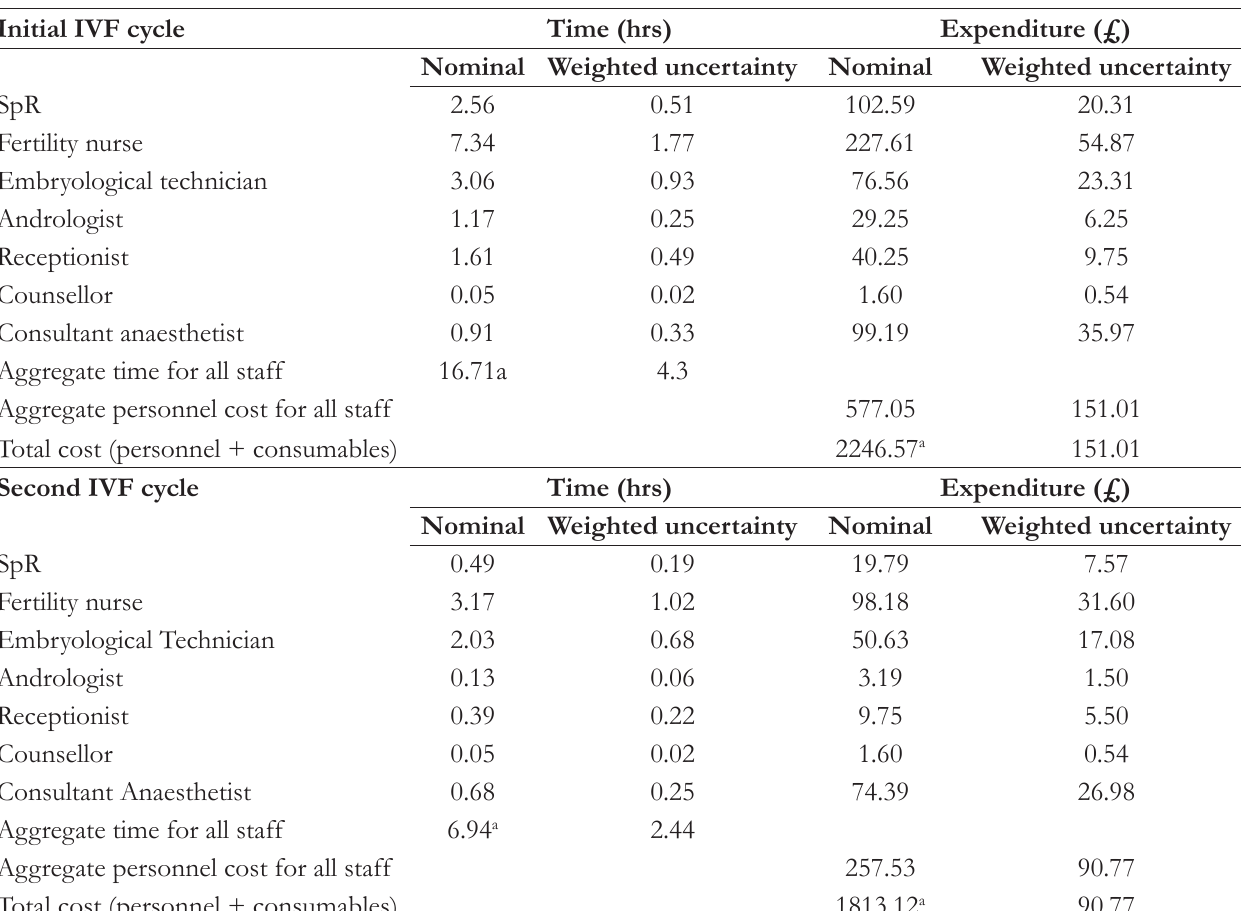
Table 3. Average Personnel Requirements and Costs Associated with First and Second fresh IVF Cycles in a UK Fertility Unit, as Used for Time-motion